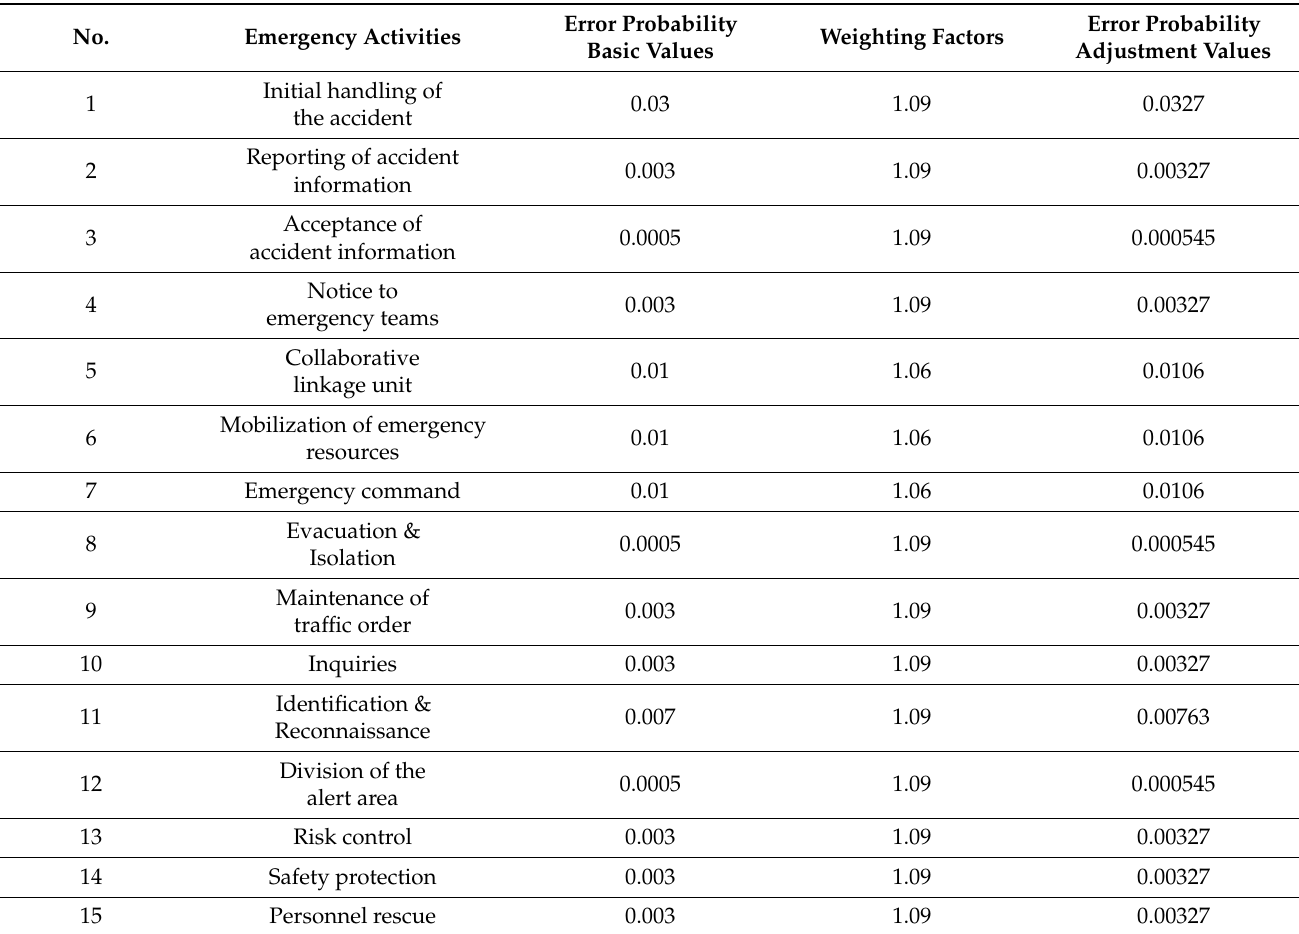
Table 9. Human error probability adjustment